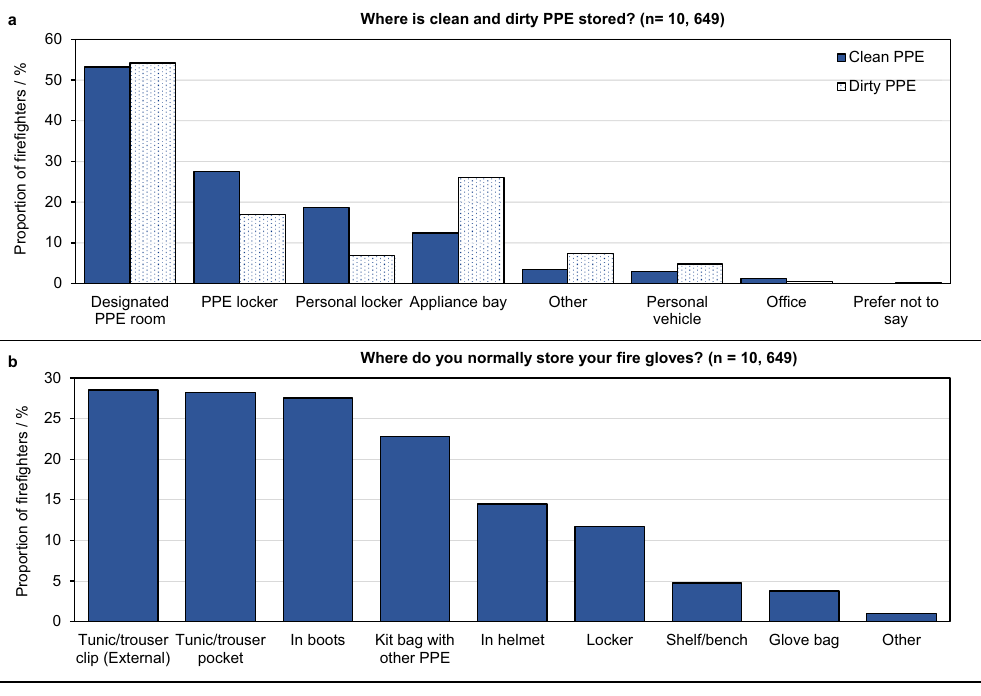
Figure 5. PPE storage in the UK Fire and Rescue Service. The proportion of total surveyed firefighters indicating: ( A ) where clean and/or dirty PPE is normally stored, and ( B ) where fire gloves are normally stored. Note that firefighters were able to select more than one location for the storage of clean/dirty PPE and fire